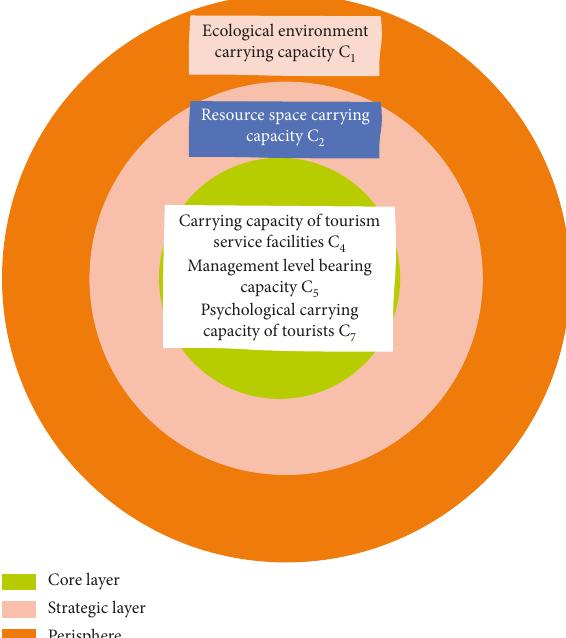
Figure 4: Relationship between the restrictive indicators of tourism environmental carrying capacity and